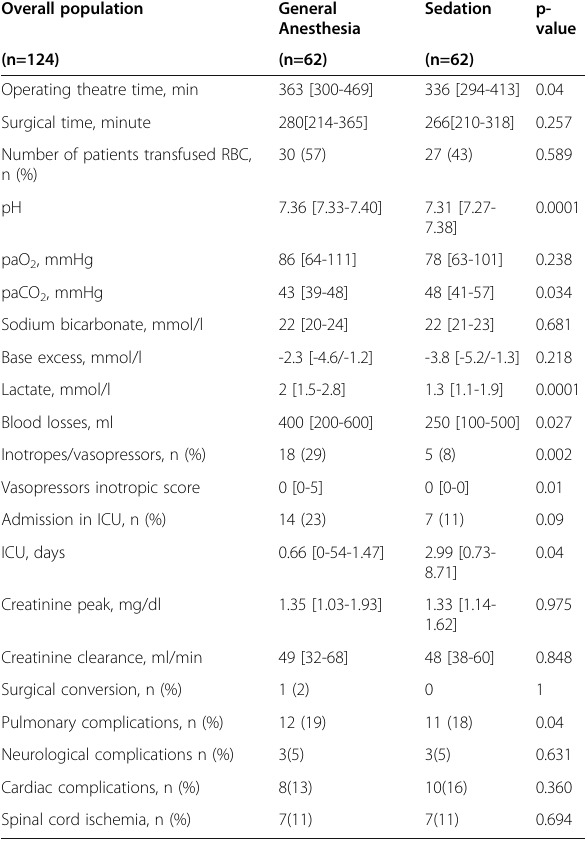
Table 2 (abstract A73). Perioperative data Overall